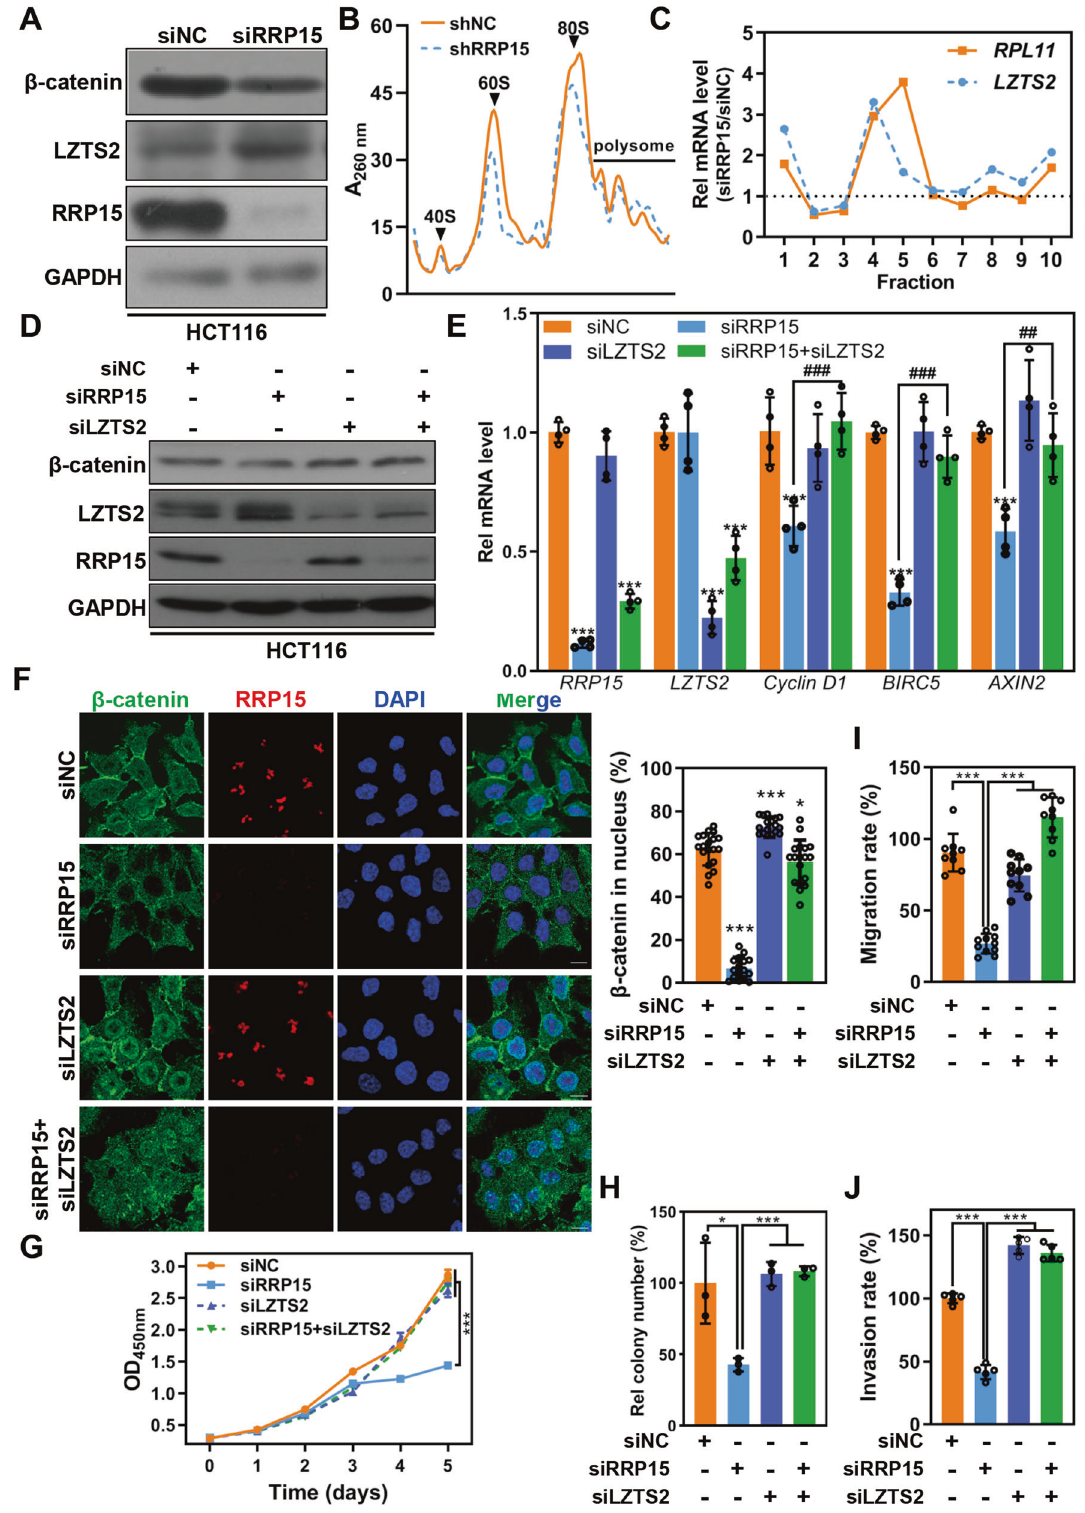
Western blot and immuno fl uorescence analyses Cells were harvested or fi xed for Western blot or immuno fl uorescence analysis as previously described [35]. In brief, for Western blot, cells were harvested and lysed in RIPA buffer. Cell lysates with equal amount of total protein were subjected to SDS-PAGE, transferred to